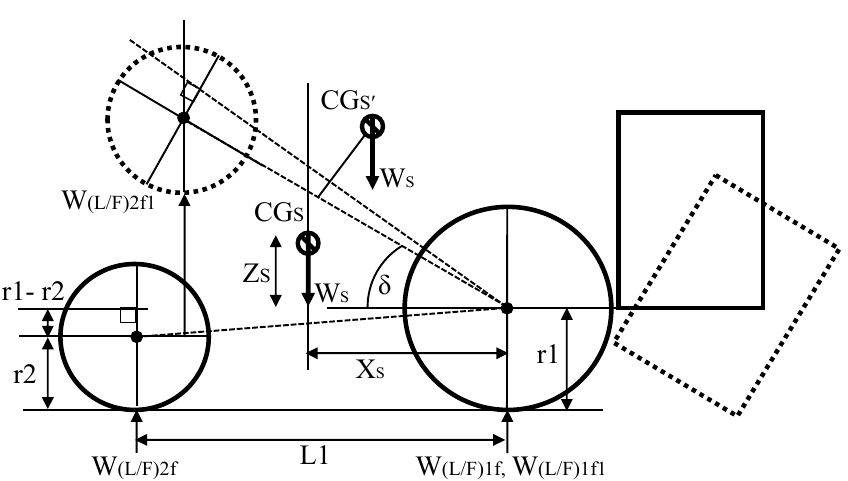
Figure 2. Schematic diagram for center of gravity (CG) determination of the tractor–collector system under normal and inclined conditions. Table 2. Mass distribution of the tractor and tractor with radish collector.